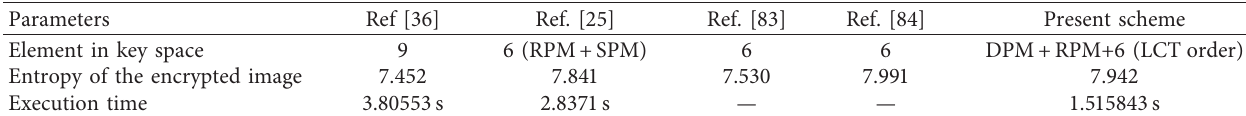
Figure 14: (a) 3D plot of Dirac delta function; (b) Dirac delta function; (c) decrypted image of DRPE with CPA; (d) DRPE encrypted image with CPA; (e) encrypted image with DPM phase key. Table 5: Quantitative comparison